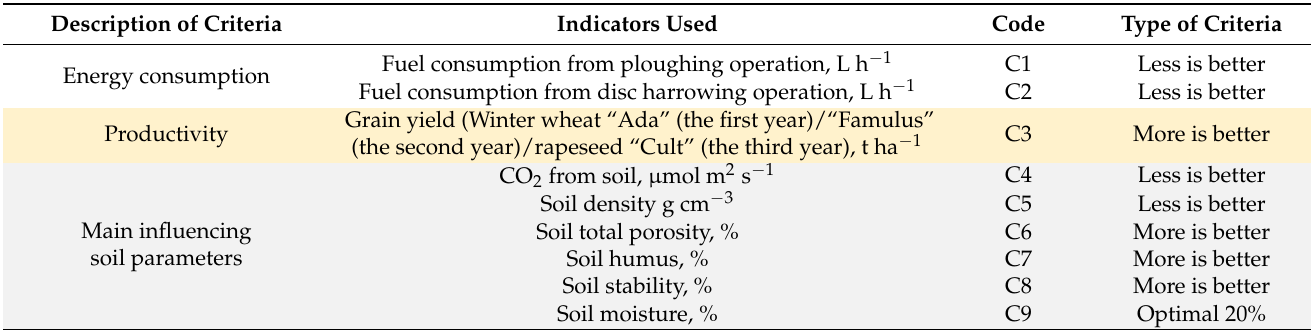
Table 2. Description and type of criteria (optimal and less or more is better) and indicators for the evaluation of alternatives. Description of Criteria Indicators Used Code Type of Criteria Energy